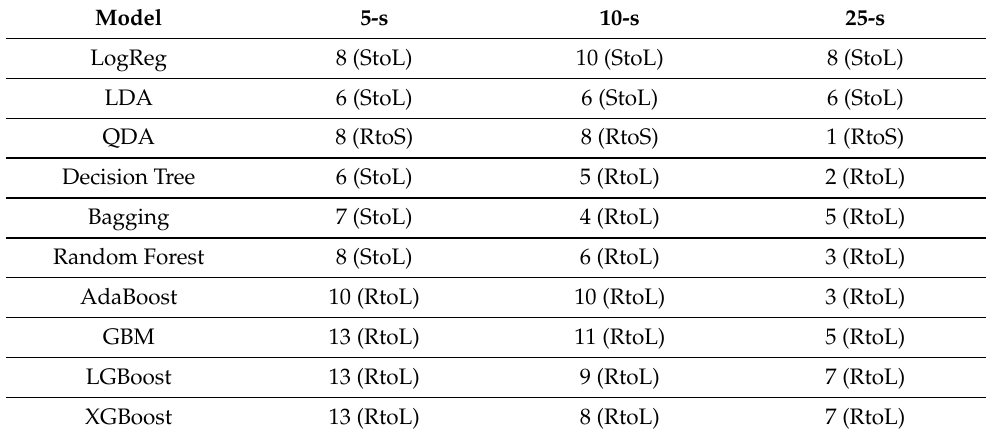
Table 10. Best transition matrix feature rank using permutation feature